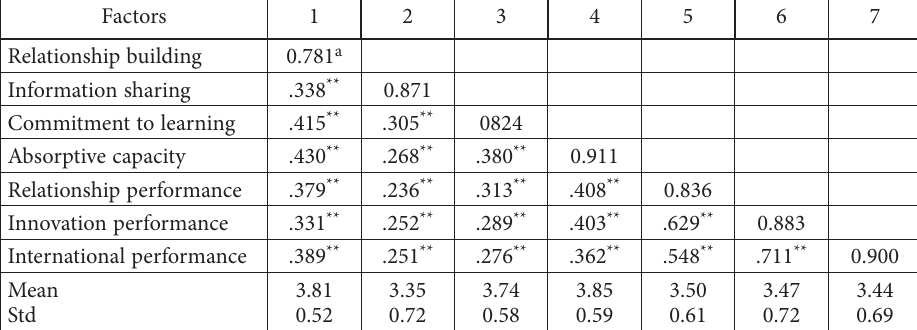
Table 4. Variables correlations and discriminant